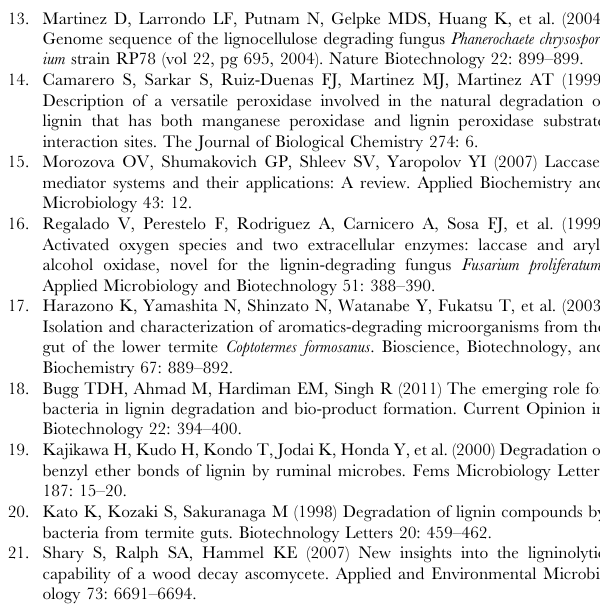
Table S1 Proteins identified in MudPIT analysis, with Necha 2.0 genomic database protein accession number, gene name, and protein score statistics from ProteinPi- lot software.